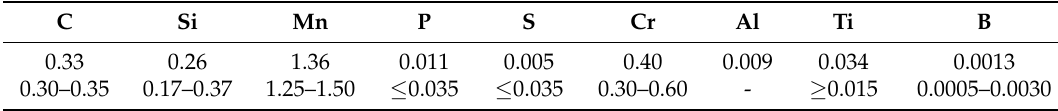
Table 1. Chemical compositions of 33MnCrTiB, wt